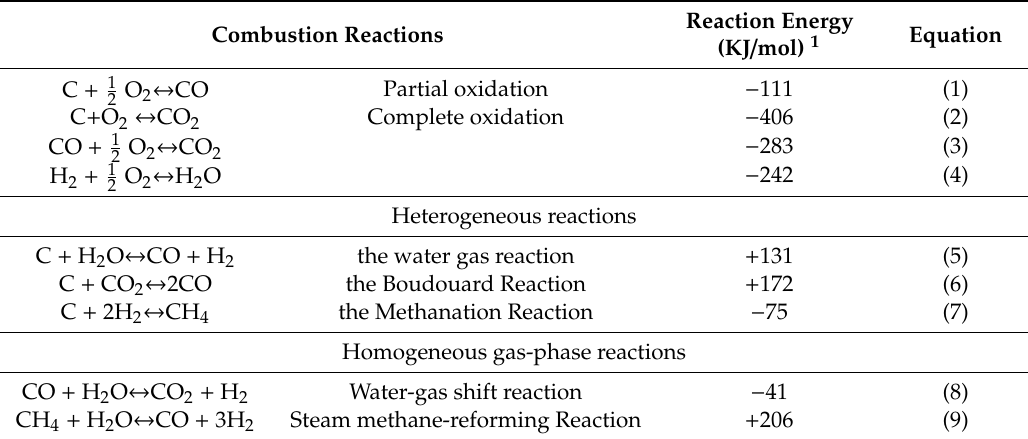
Table 3. Typical reactions in